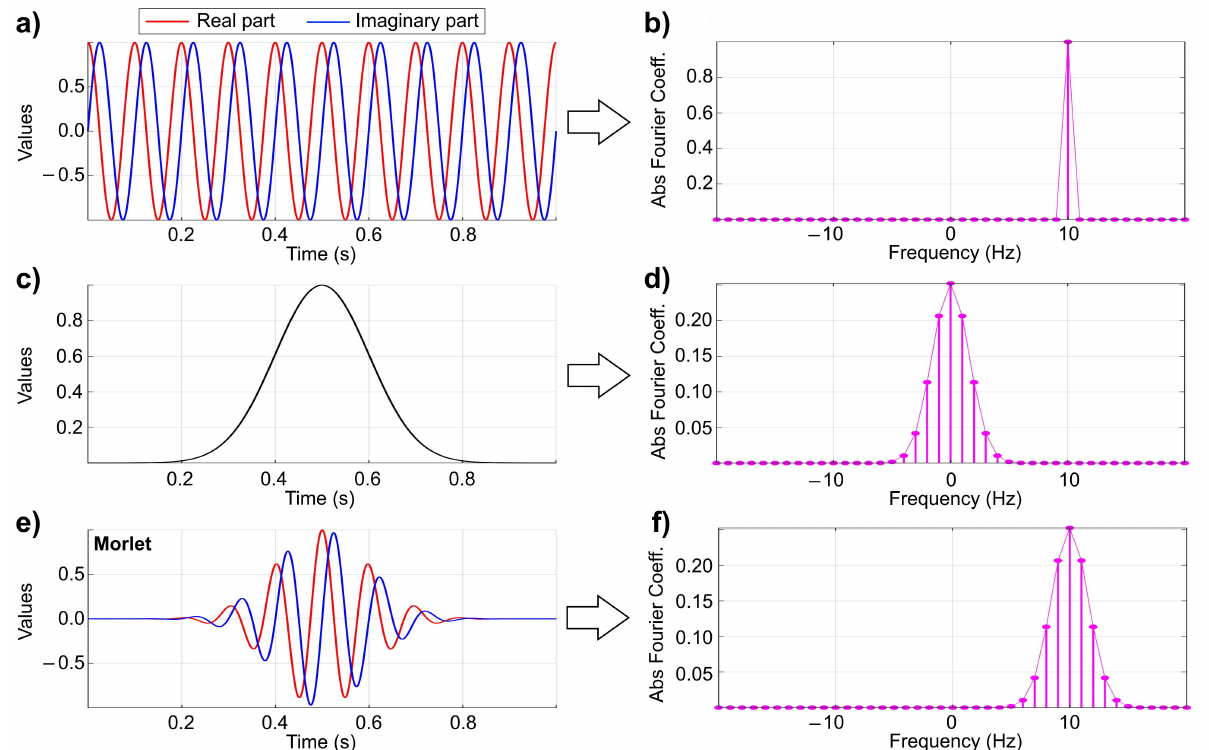
Figure 4. Morlet wavelet of frequency 10 Hz and its analyses (1000 samples per second). ( a ) Sinusoids of frequency 10 Hz, ( b ) DFT spectrum of panel a, ( c ) a Gaussian function, ( d ) DFT spectrum of panel c, ( e ) a Morlet wavelet, and ( f ) DFT spectrum of panel